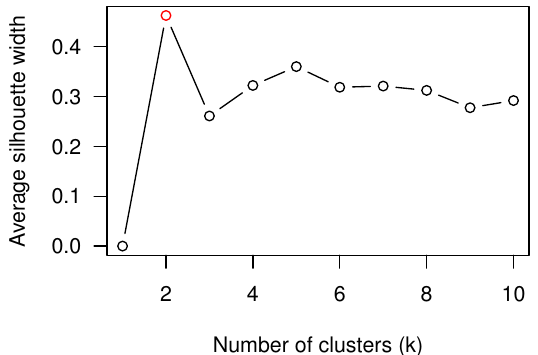
Figure 9. Estimation of the optimal number of clusters by using the average silhouette width.